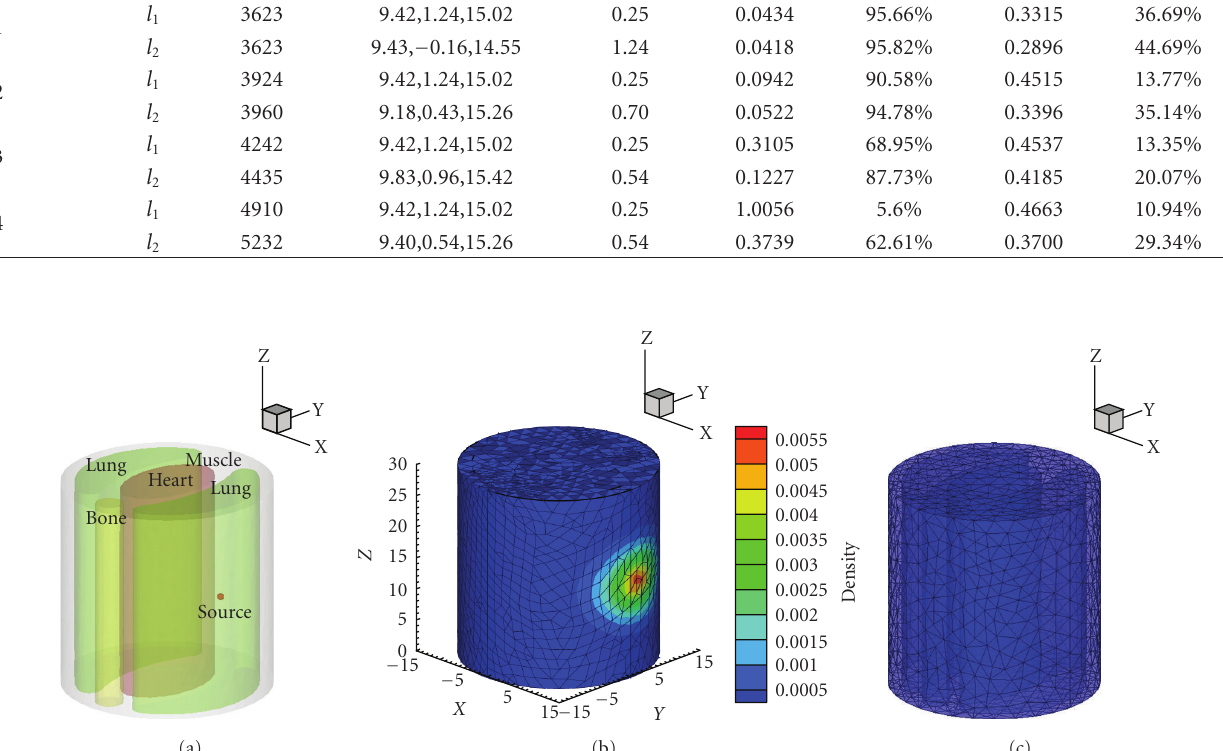
Figure 1: (a) Mouse chest phantom composed of muscle, lungs, heart, and bone, with one source in right lung. (b) The forward discretized mesh and the photon distribution on the surface. (c) The initial mesh used in the adaptive reconstruction, with average edge size 1.637 mm.